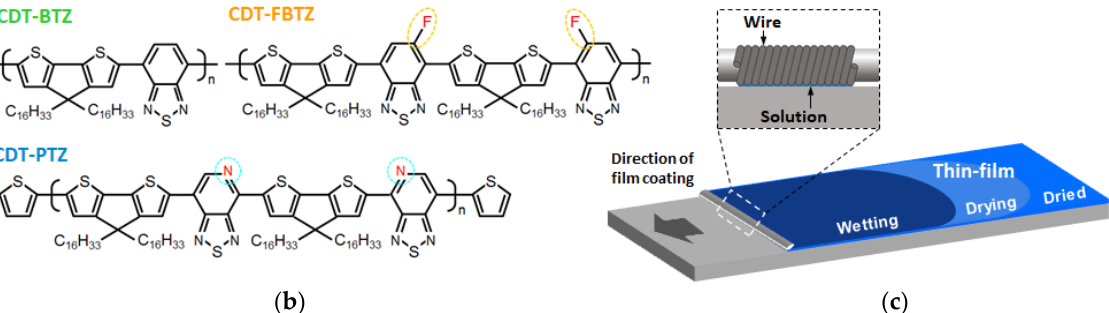
Figure 1. ( a ) Device configuration of the PFET used in this study and corresponding SEM images. ( b ) Molecular structures of the D–A-type semiconducting copolymers. ( c ) Schematic illustration of the wire-bar-coating process.